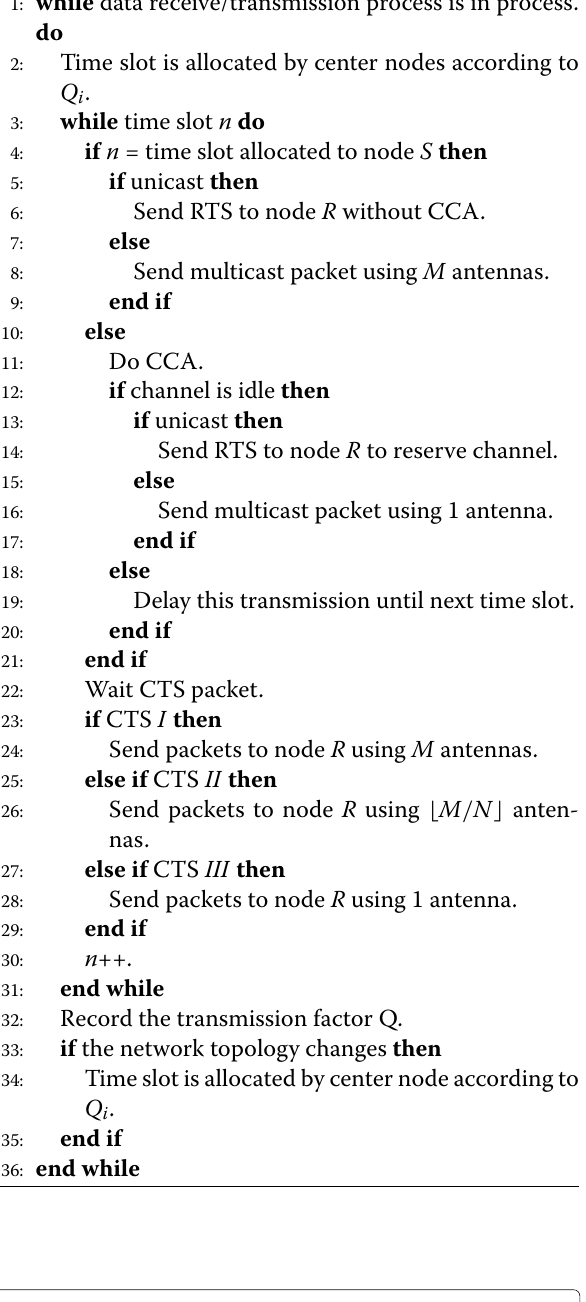
Algorithm 2 Operation process of node